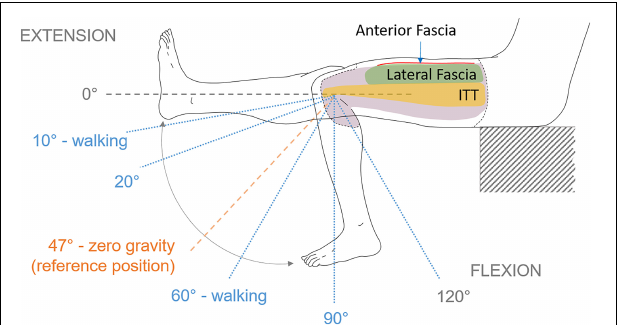
FIGURE 2 | Lateral view of the thigh during the leg flexion-extension movement with angles and areas of interest identification. Lateral fascia, anterior fascia and ITT are the three areas of interest. The leg movement starts from full extension of the knee until maximum reachable flexion. Knee angle of 47 ◦ corresponds to the reference position used for digital image correlation. Angles of 20 ◦ , 60 ◦ , and 90 ◦ are arbitrary chosen to look at strain fields.